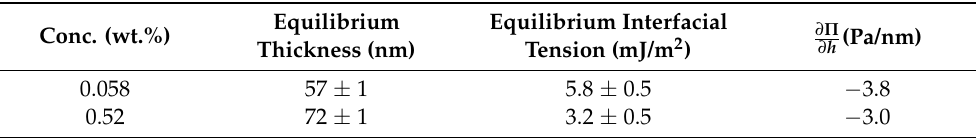
Table 1. Experimental data for film thickness, interfacial tension, and the derivative of disjoining pressure that were used in the model.